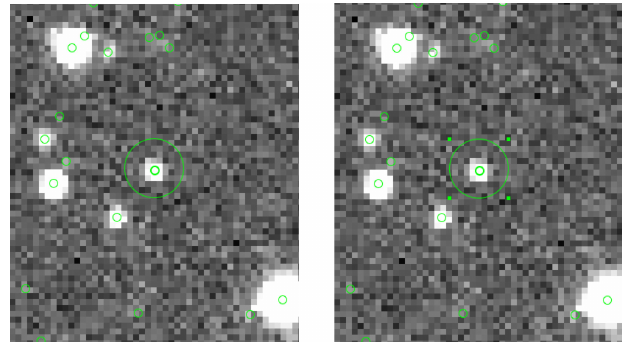
Fig. 44.— A circular region, not selected (left) and selected (right). The much smaller green circles are the catalog indicators and not related to the region itself